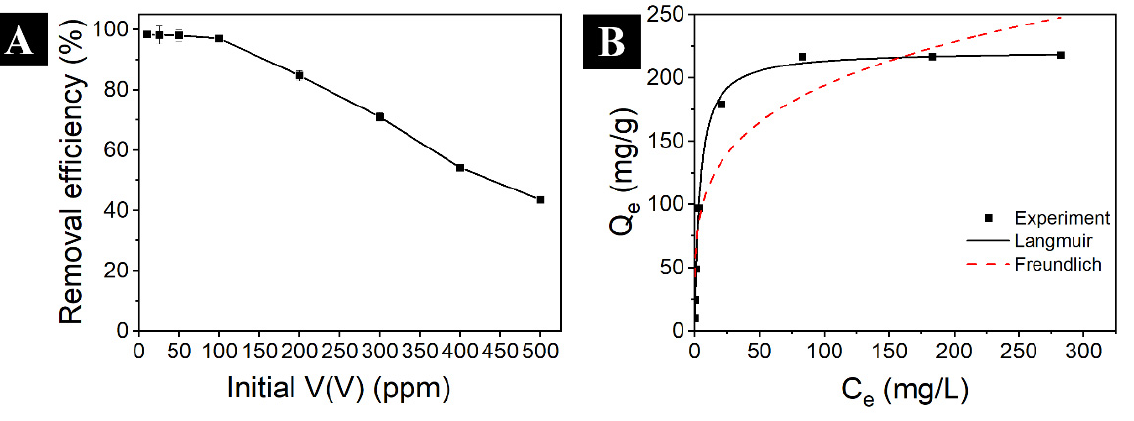
Figure 6. Isotherm studies. ( A ) removal efficiency versus V(V) initial concentration, ( B ) adsorption capacity versus equilibrium concentration. Conditions: CS 2 C@SBA − 3 dosage = 1.0 g/L, pH value = 3.0, experimental temperature = 298 K, contact time = 24 h.